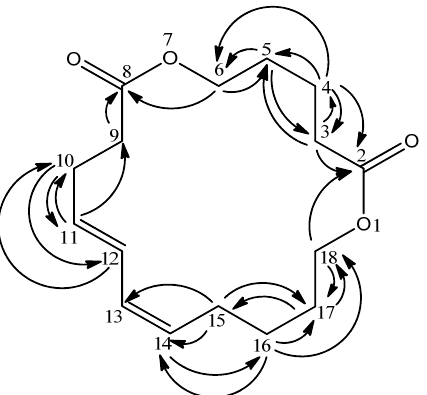
Figure 2. HMBC correlations in 1